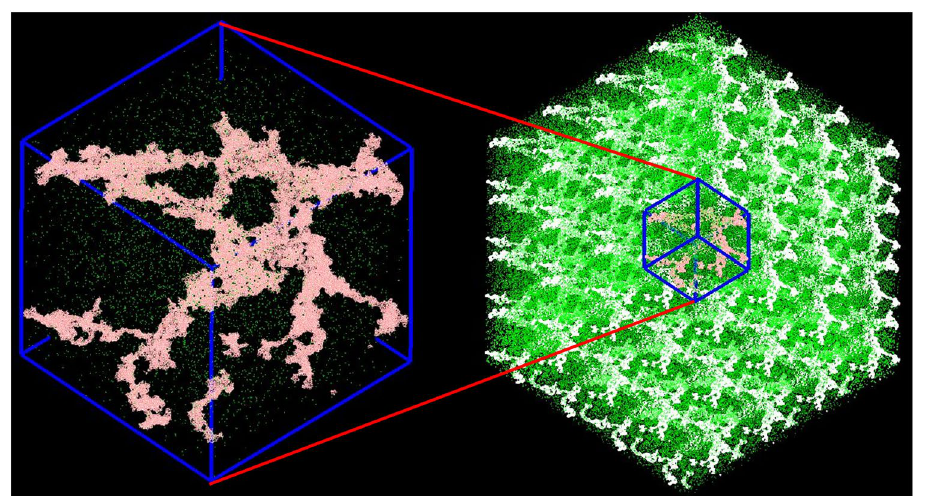
Figure 2. Schematic drawing of the periodic boundary conditions. The simulation box is shown on the left. The large system (right) consisting of an infinite number of repeating unit cells (left) represents the macro-scale structure of the